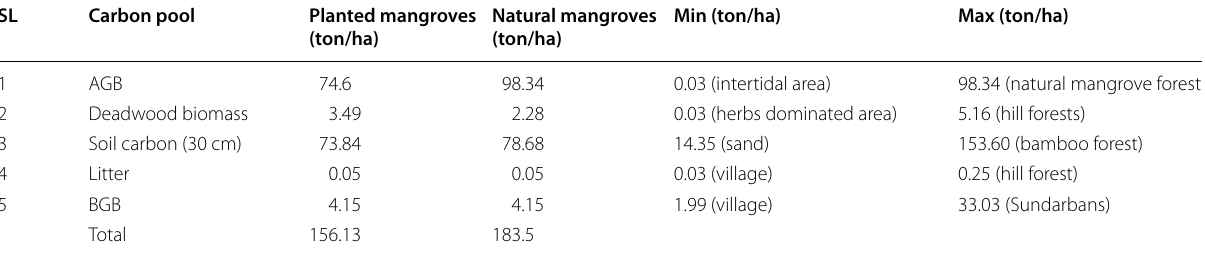
Table 2 Amount of biomass per hectare of mangrove forests for both planted and natural mangrove forests in the coastal zone of Bangladesh) Carbon